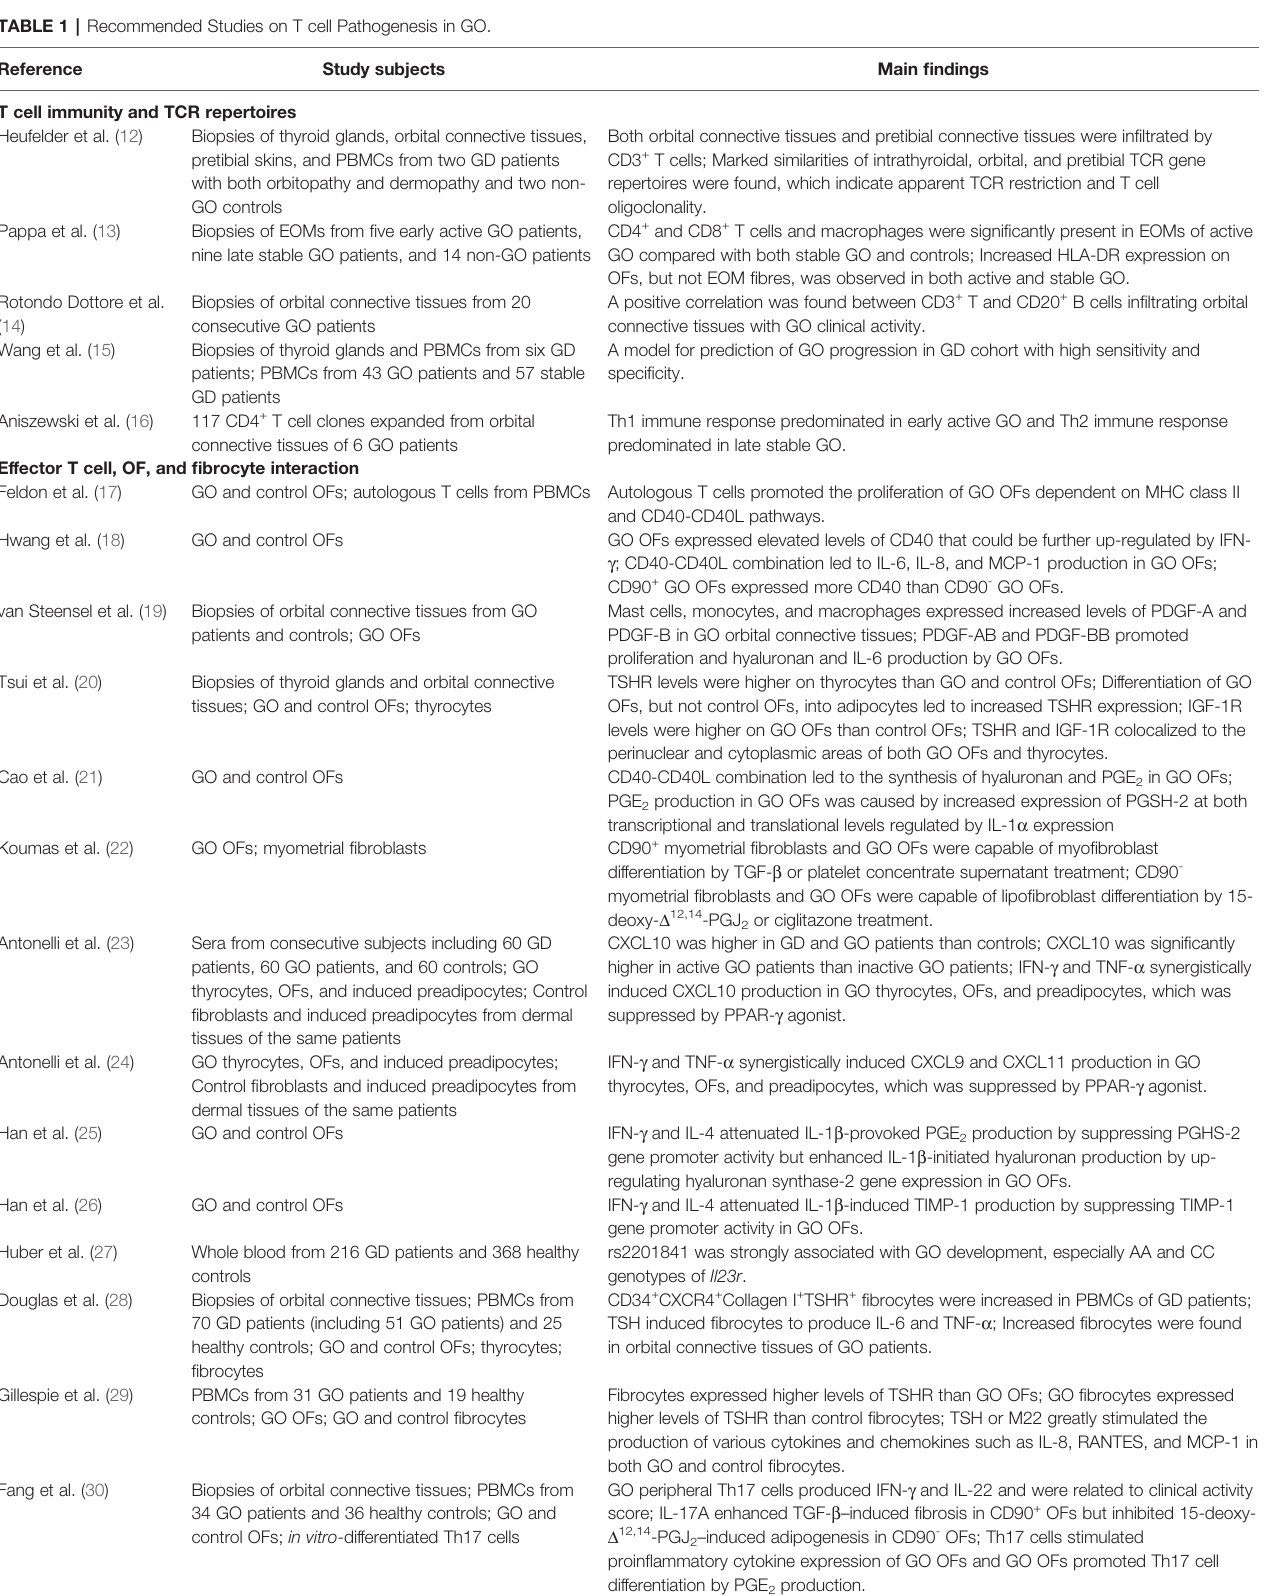
TABLE 1 | Recommended Studies on T cell Pathogenesis in GO.